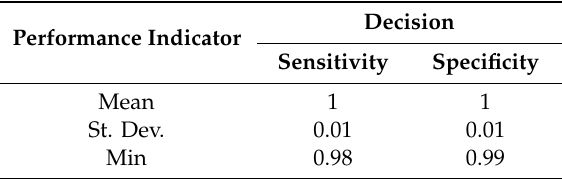
Table 1. Fault detection results for 20 experimental trials.